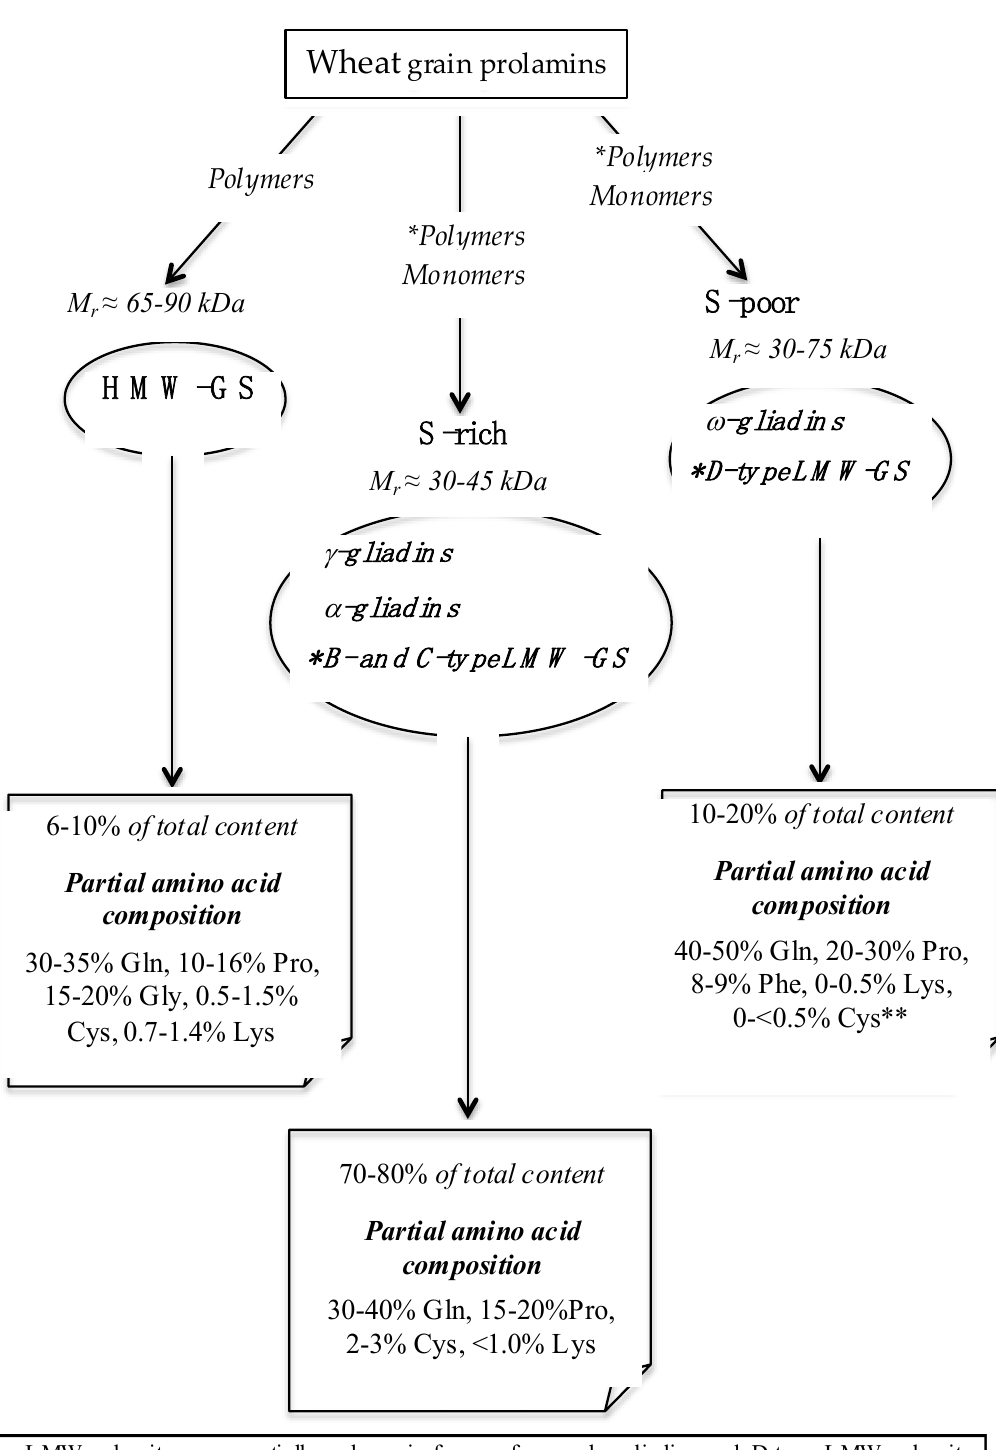
Figure 1. Schematic representation of types and peculiarities of wheat gluten proteins (gliadins and glutenins-GS; modified from